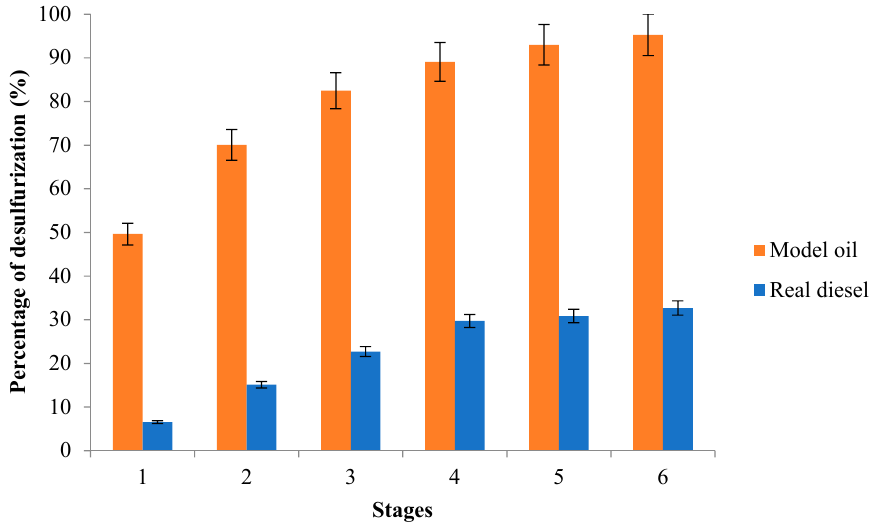
Figure 10. Desulfurization performance of ChCl-PEG (1:4) in 100 ppm model oil and real diesel fuel.